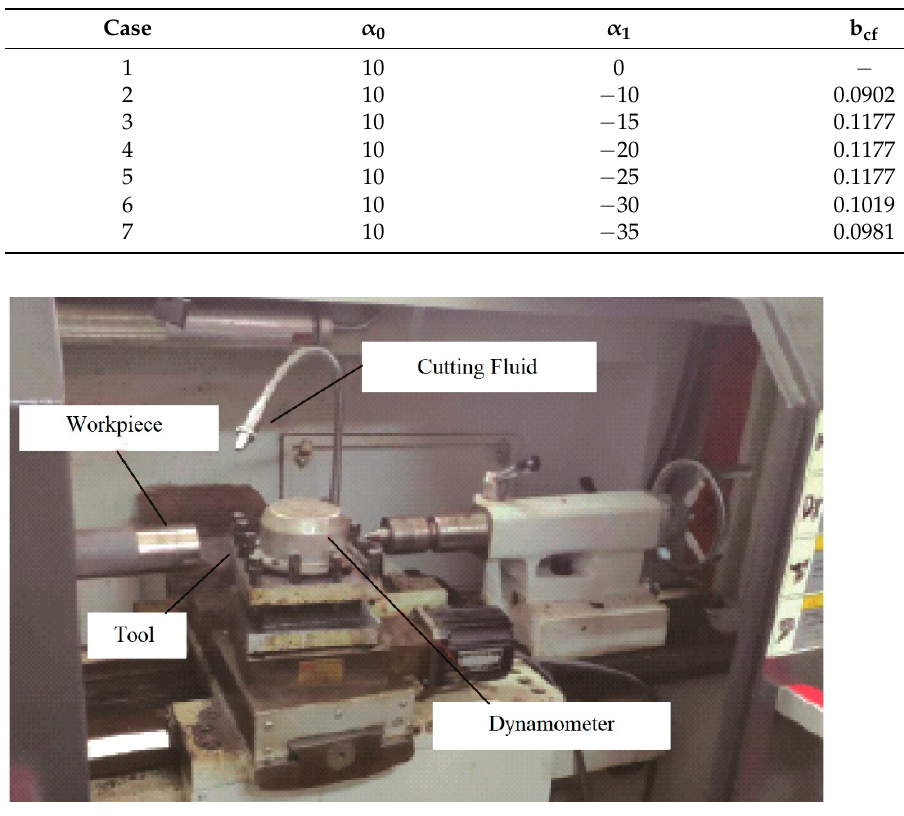
Table 2. Tool edge geometry in cutting tests with carbide tools.